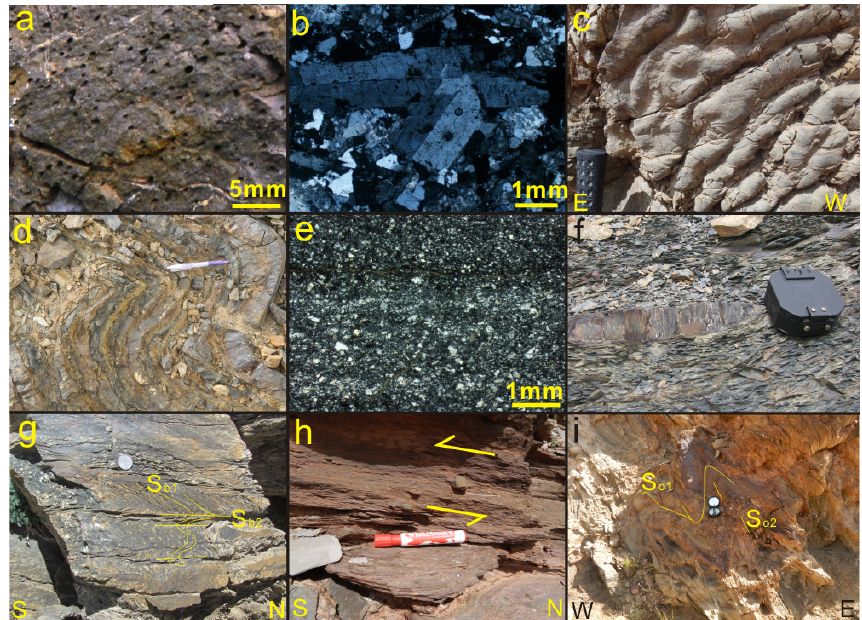
Figure 3. Field photographs and micrographs showing metamorphism and deformation in the different units: (a) amygdules in basalt from the ophiolitic mélange, west of Rongma; (b) thin sections of gabbro, west of Rongma; (c) load cast in mudstone from the southern part of the sedimentary mélange; (d) folded chert from the sedimentary mélange west of Jiangaizangbu River; (e) thin sections of siltstone, west of Rongma, which show that the ophiolitic and sedimentary mélanges did not experience any significant metamorphism; (f) typical main foliation in the sedimentary mélange wrapping around competent blocks, here sandstone; (g) outcrop view of basement deformation: S b1 is folded, during which a second, crenulation cleavage S b2 developed. (h) Pressure shadow around pebbles in the Ordovician siltstone indicate top-to-south shearing. (i) Near the thrust where ophiolitic mélange is thrusted over Ordovician sediments (Fig. 6b), their deformation is more intense, with the local development of an axial planar S o2 .